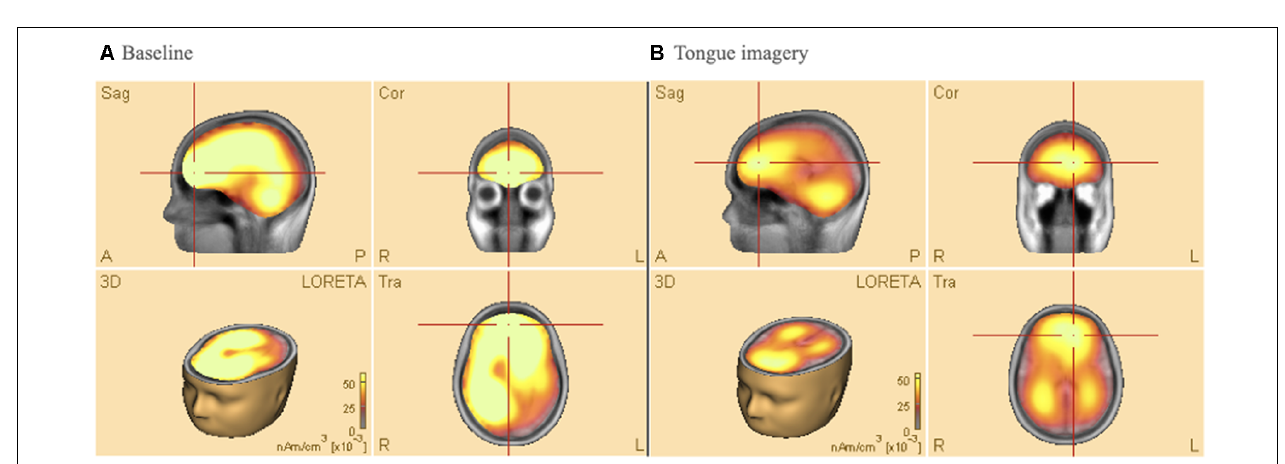
FIGURE 4 | Low-resolution electromagnetic tomography (LORETA) source analysis during (A) baseline (B) tongue imagery. On average, the mirrored intensity of the brain activity was reduced for the tongue imagery in premotor, motor, parietal and visual areas bilaterally ( p < 0.01). The orange/yellow scale is a positive one, i.e., the more high, the more intense. Orange/Yellow shades indicate decreased sources. Abbreviations: L: left; R: right; A: anterior; P: posterior; Sag: Sagittal; Cor: